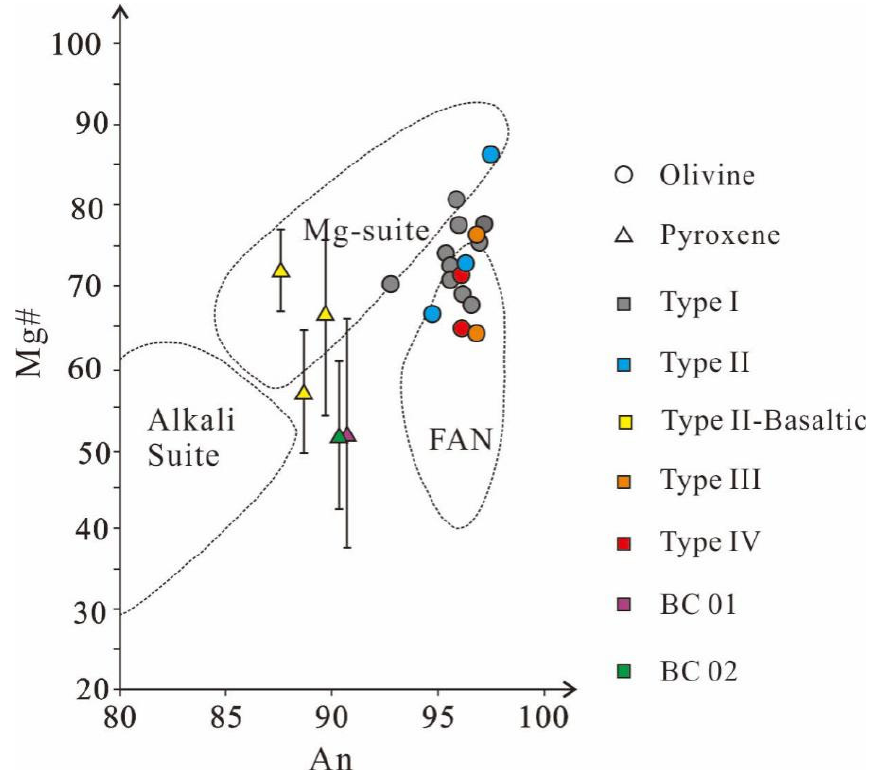
Figure 9. Mg # value of ferromagnesian minerals versus An value of coexisting plagioclases in clasts after [27]. Symbol shapes indicate mineral types, color in squares indicate rock types.